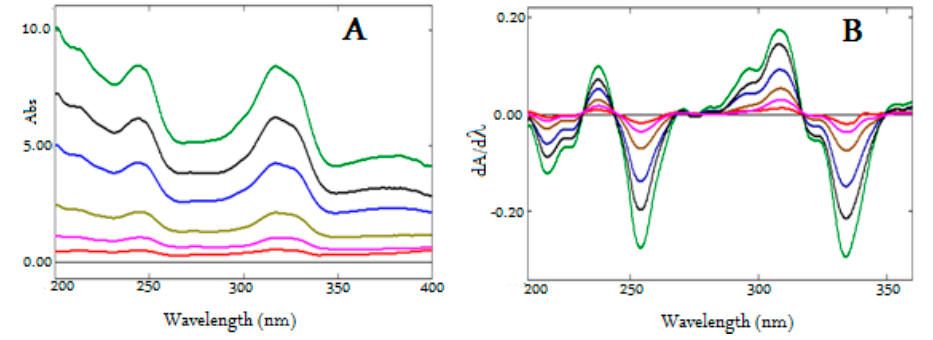
Figure 5. Ratio UV spectra FLX (1–16 µg/mL) using 4 µg/mL solution spectra of MOX as devisor ( A ), First derivative of ratio spectra of FLX (1–16 µg/mL, B ).